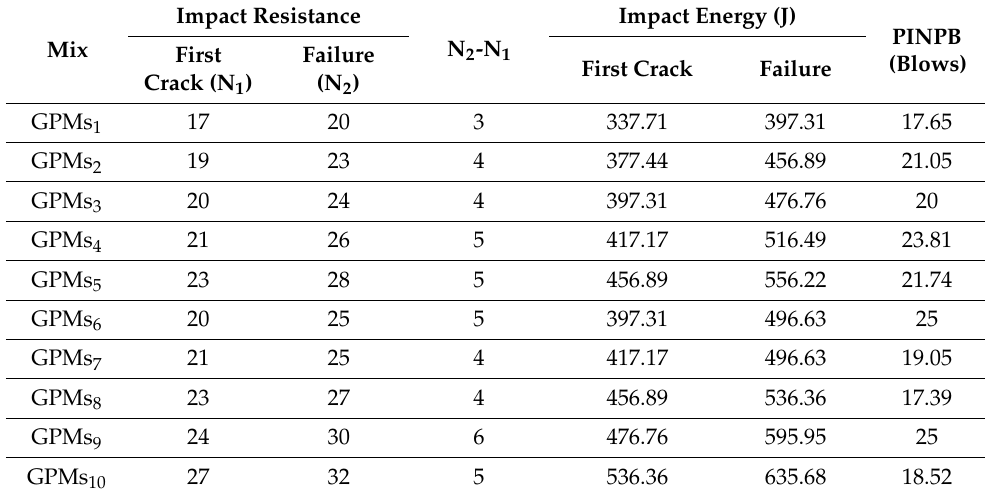
Table 3. Impact resistance of all studied geopolymer specimens at the age of 28 days.